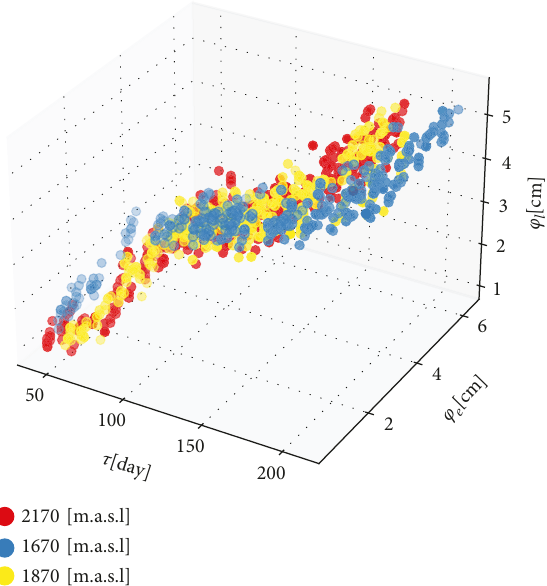
Figure 2: Distribution of diameters and days after defoliation for the three